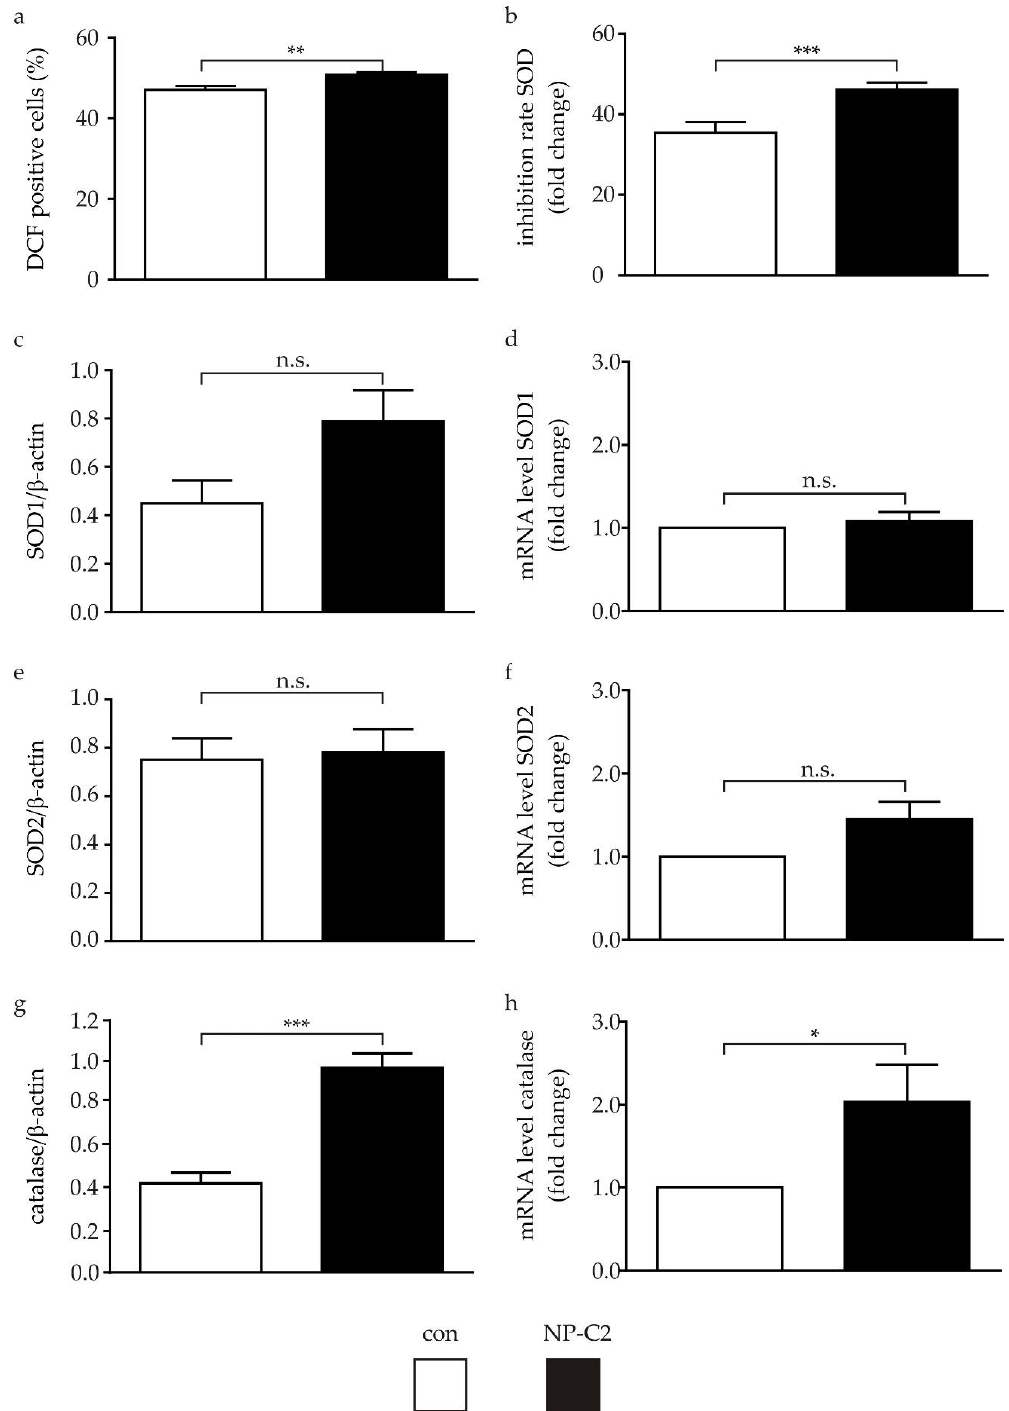
Figure 3. Determination of reactive oxygen species (ROS) and proteins of the antioxidative defense system. ( a ) Determination of ROS by dichlorodihydrofluorescein (DCF) assay revealed a small difference between control and NPC2-deficient cells. ( b ) Inhibition rate of SOD activity significantly increased in NPC2-deficient cells. ( c ) Analysis of the protein level of SOD1, the mRNA level for SOD1 ( d ), the protein level of SOD2 ( e ), and the mRNA level of SOD2 ( f ) were not altered in NPC2-deficient cells compared to the control cells. ( g ) The protein level of catalase, as well as the mRNA level ( h ), were significantly higher in the NPC2-deficient cells in comparison to the control cells. Examples of membranes for the Western blot analysis are shown in Figure S2. * = p < 0.05, ** = p < 0.01, *** = p < 0.001. con = control cell line; NP-C2 = NPC2-deficient cell line; n.s. = not statistically